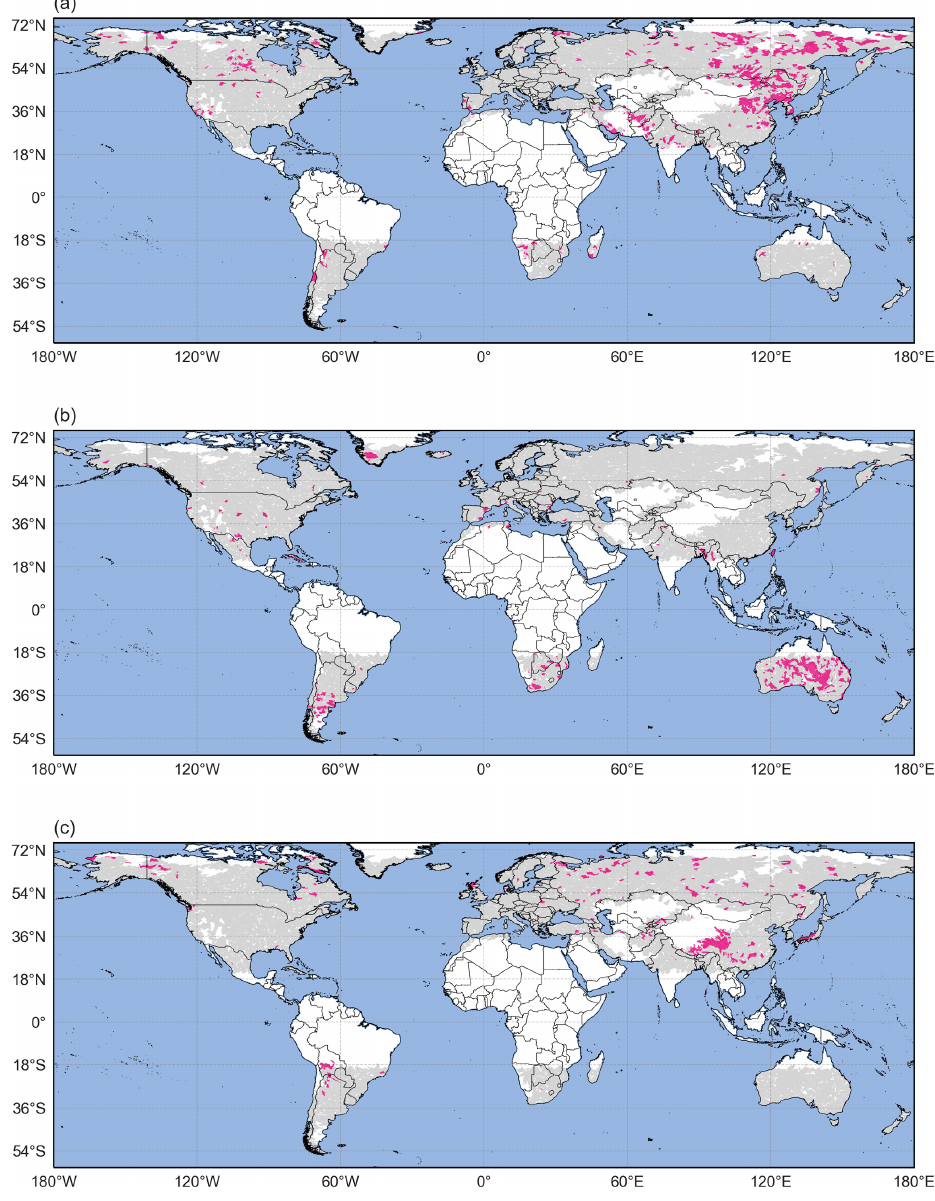
Figure 7. (a) Catchments where S cl and S cont are both above their respective 75th percentile (pink areas). (b) Catchments where S cl < 25p and S cont > 75p (pink areas) and (c) catchments where S cl > 75p and S cont < 25p (pink areas). In all panels, catchments in grey do not satisfy the respective conditions, whereas catchments in white were excluded from the analysis according to the criteria defined in Sect. 2.1.